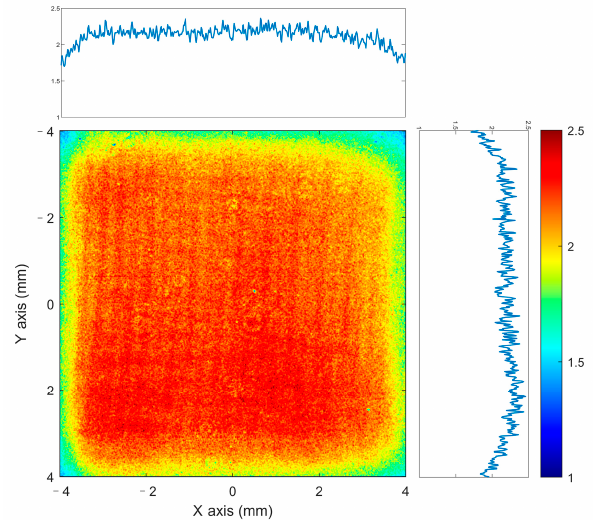
Figure 4. Gain distribution of Nd:glass under total pump energy of 9.02 J.